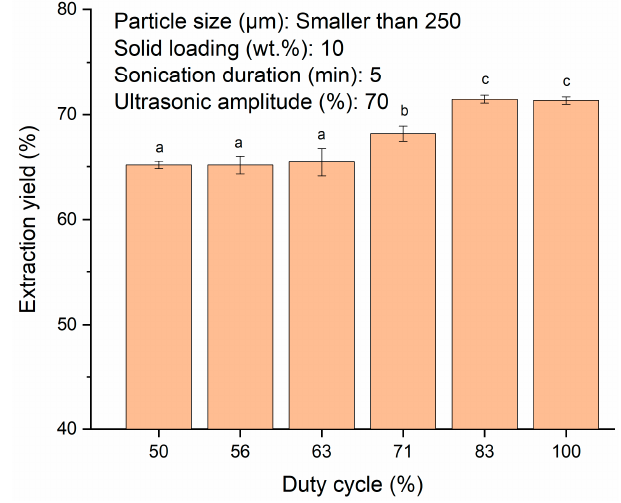
Figure 4. Effect of duty cycles (50, 56, 63, 71, 83 and 100%) on extraction yield of starch from SPW. Different letters indicate the values are significantly different ( p < 0.05).